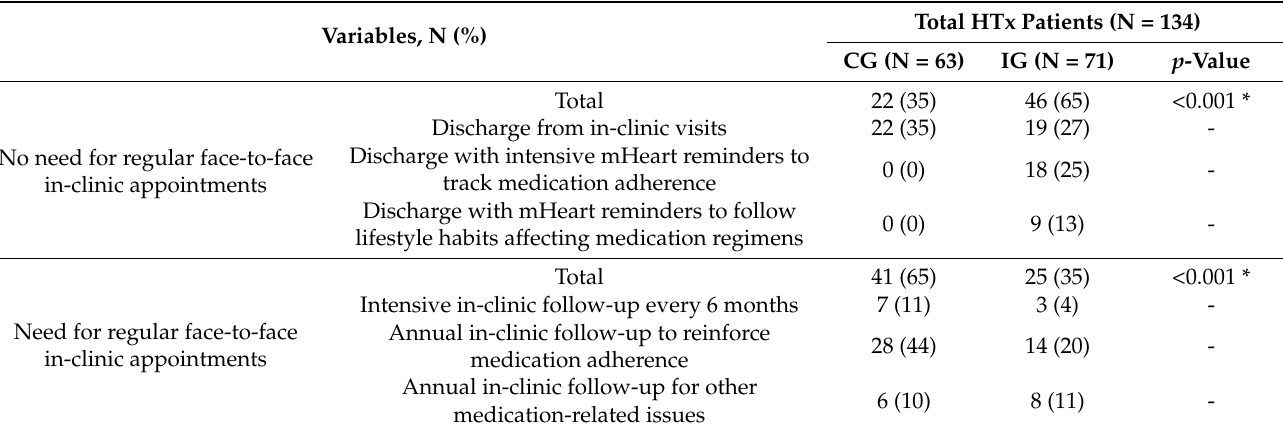
Total HTx Patients (N =